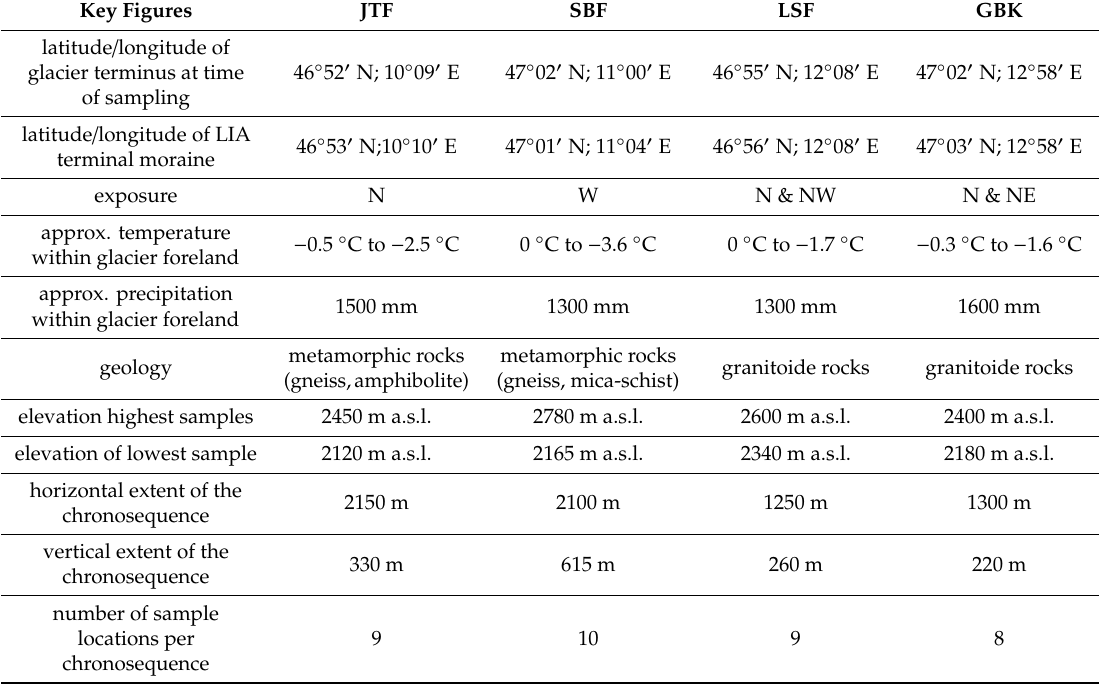
Table 1. Key figures for the environmental conditions and the chronosequences sampled within the four glacier forelands